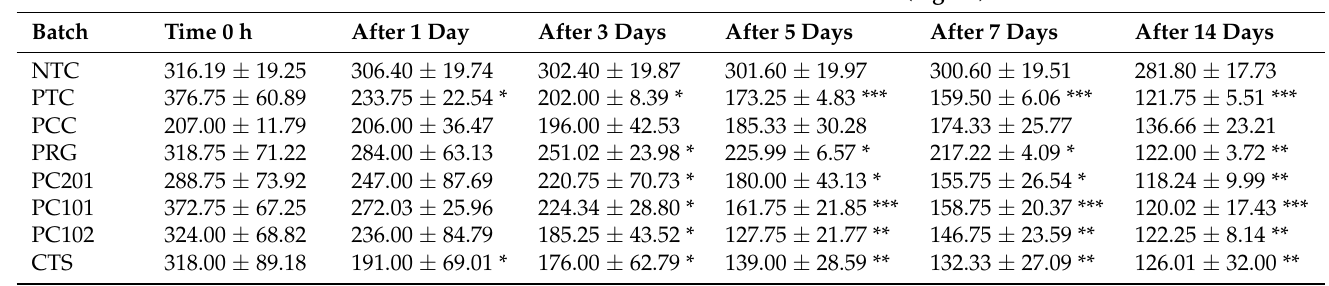
Table 4. Absolute values of the blood glucose level over a period of 14 days with daily administration of the various formulations.